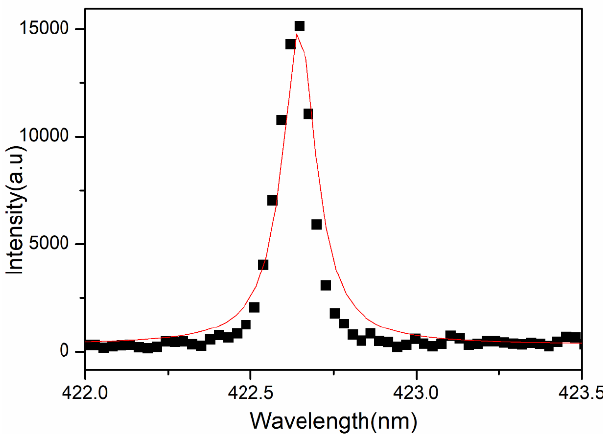
Figure 4. Lorentzian plot for estimation of electron density for transmission line. The plasma temperature from the Boltzmann plot is 10,400 ± 235 K, and electron density is estimated using Equation (8) is 1.06 × 10 18 cm − 3, which is greater than the value of electron density (1.48 × 10 16 cm − 3 ) for the McWhirter limit (Equation (7)). It can be observed that the estimated electron density in the LIP of all the samples is greater by two orders of magnitude than the minimum electron density required at any given time, confirming the validity of the LTE criteria over the entire temporal range of the present experiment which fulfills the necessary condition of